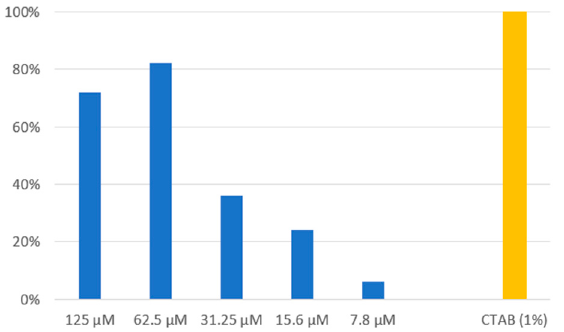
Figure 7. Dose-dependent ATP release from S. aureus ATCC 25923 exhibited by 15d . CTAB (1%) is the positive control.